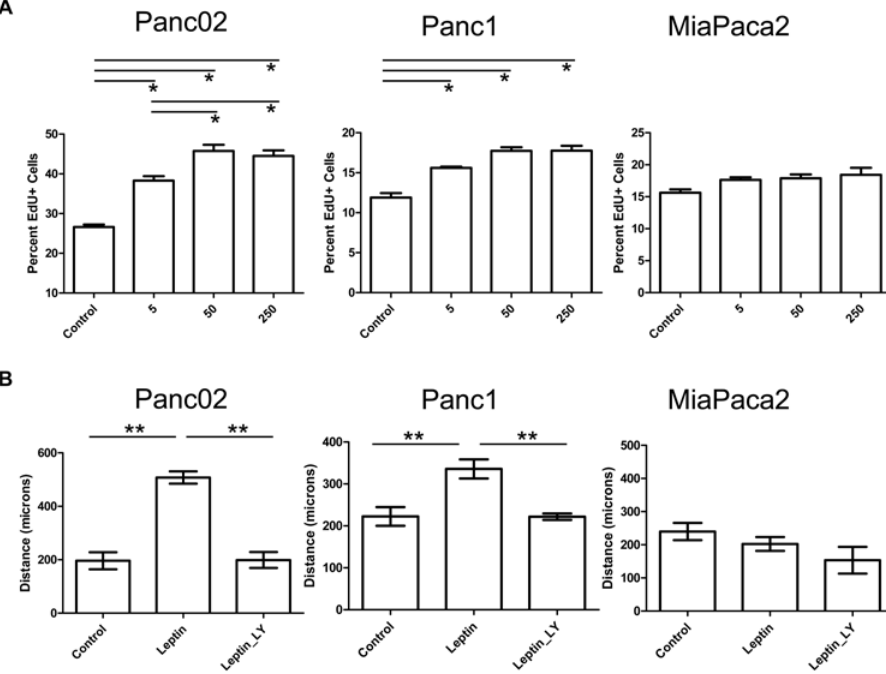
Fig 4. Leptin induced proliferation and migration of pancreatic cancer cells is cell line dependent. Leptin stimulation at 5, 50, and 250ng/ml caused an increase in proliferation assessed through EdU incorporation in murine Panc02 and human Panc1 cell lines but did not alter proliferation in human MiaPaca cells (A). Leptin stimulation caused an increase in migration recorded as distance migrated for Panc02 and Panc1 cells assessed through scratch assay which was blocked by PI3K inhibitor LY294002 (B). Statistical analysis by * ANOVA of p < 0.0001, and ** T-test of p <